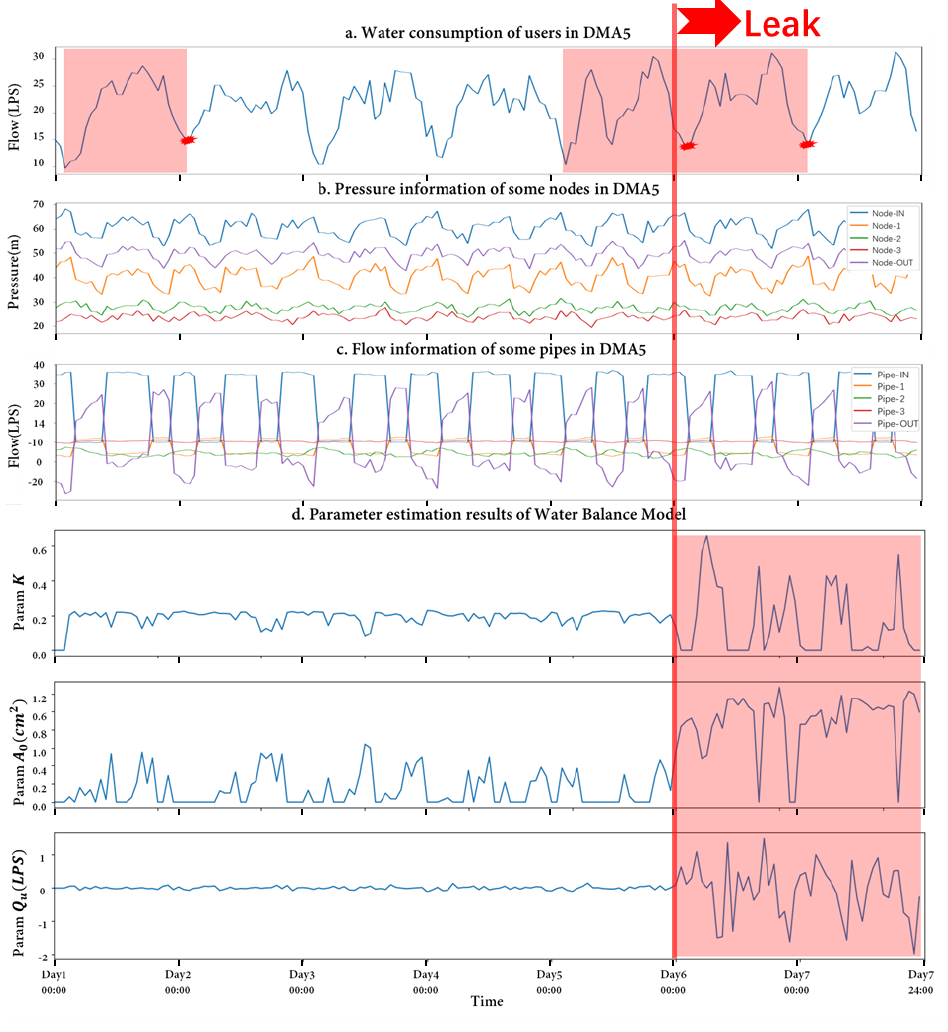
Figure 4. Simulate results of case1.